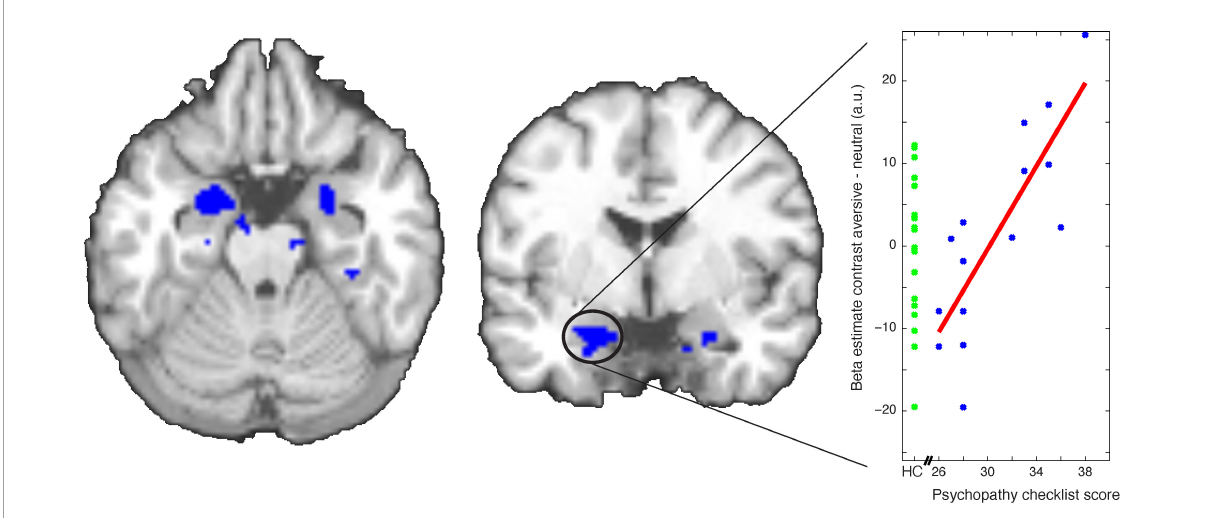
FIGURE4 Association between psychopathy severity [in terms of Psychopathy Check List-Revised (PCL-R) total score] and beta estimate contrasts [conditioned stimuli (CS) aversive–CS neutral trials] during Pavlovian conditioning. Scatterplot depicts relation between PCL-R total score and the extracted average beta estimate contrast from the p < 0.001 whole-brain uncorrected cluster within the amygdala (for illustrative purpose only). Data is also displayed for healthy controls for whom no PCL-R score was available (green